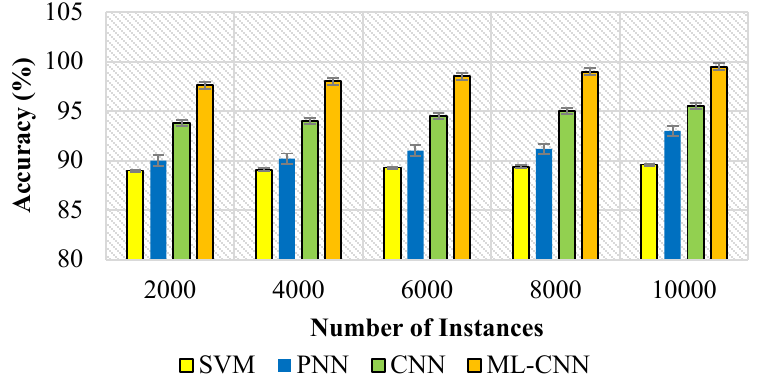
Figure 7. Accuracy vs. number of instances.